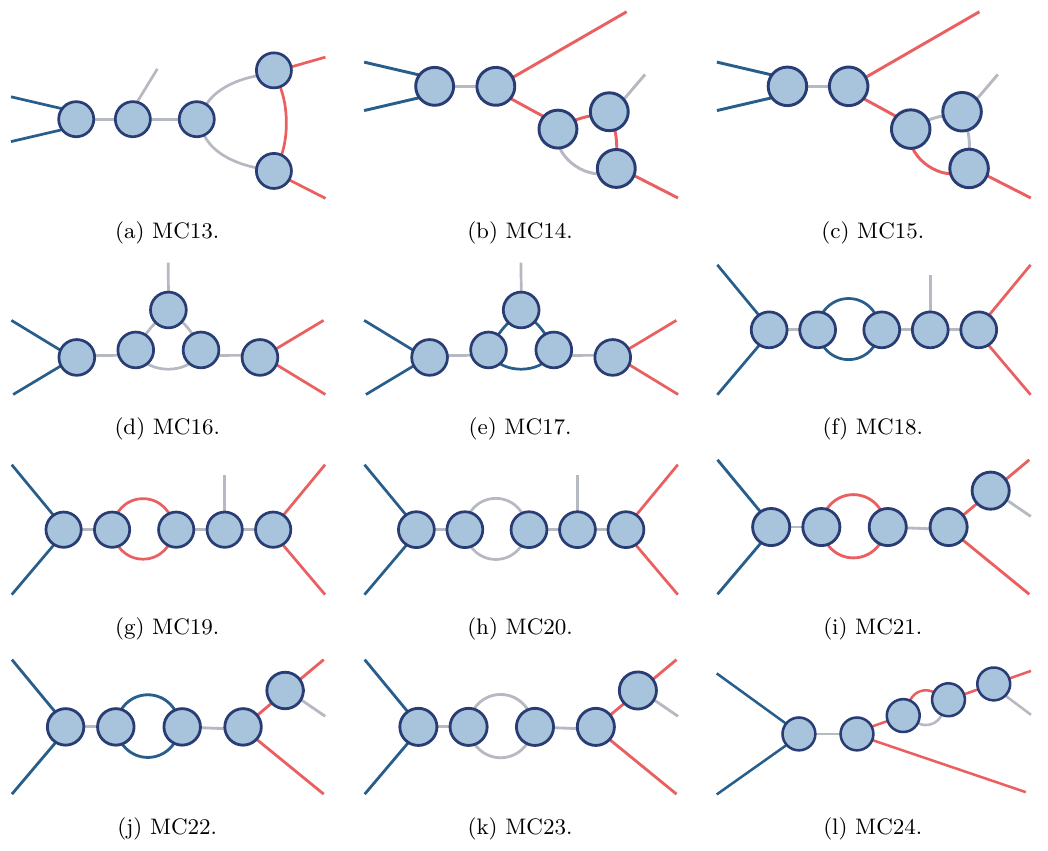
Figure 6 . Maximal cuts MC13-MC24 of the one-loop five-point amplitude. Light blue blobs represent three-point amplitudes, and exposed legs represent on-shell propagators.